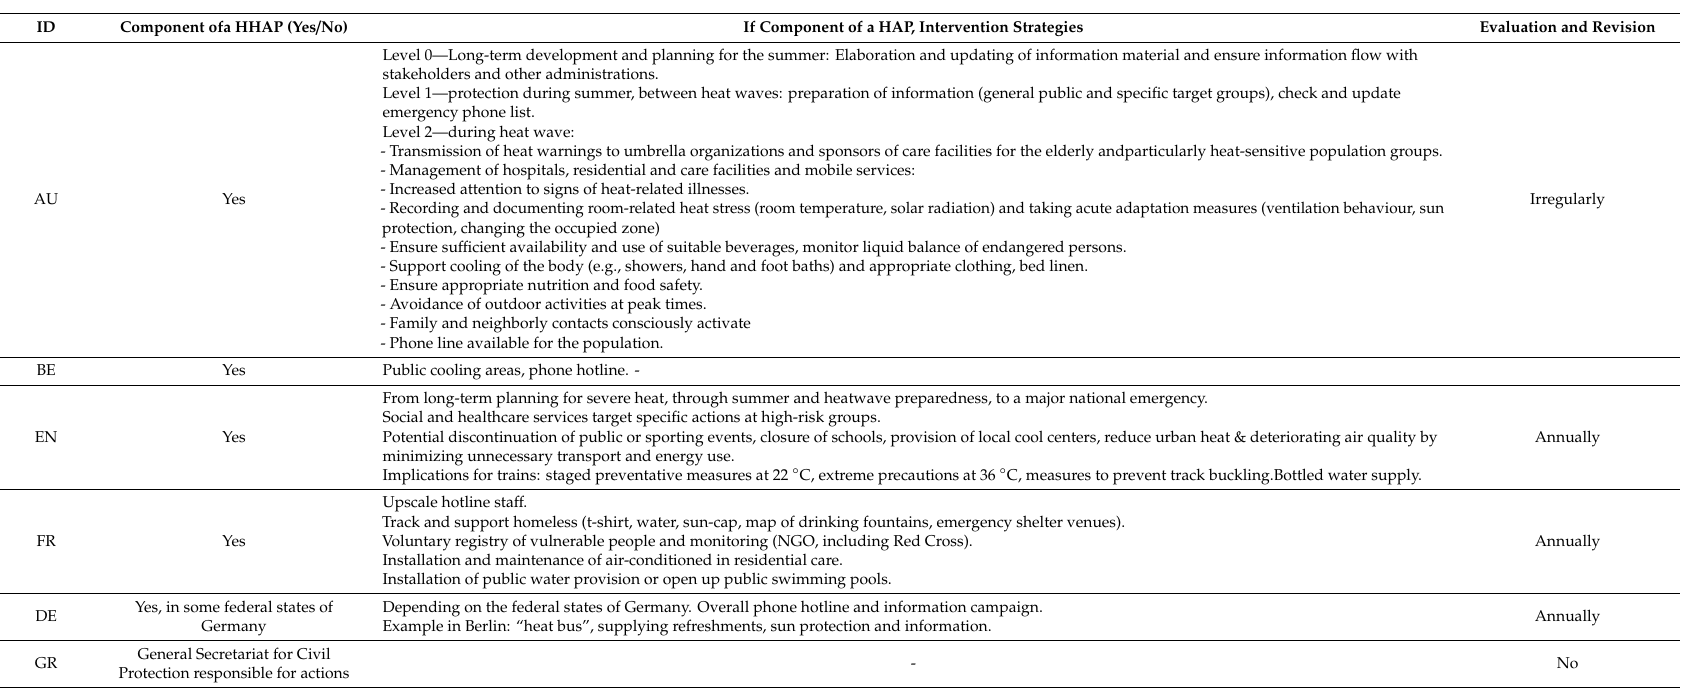
Table 3. Characteristics of the heat-health action